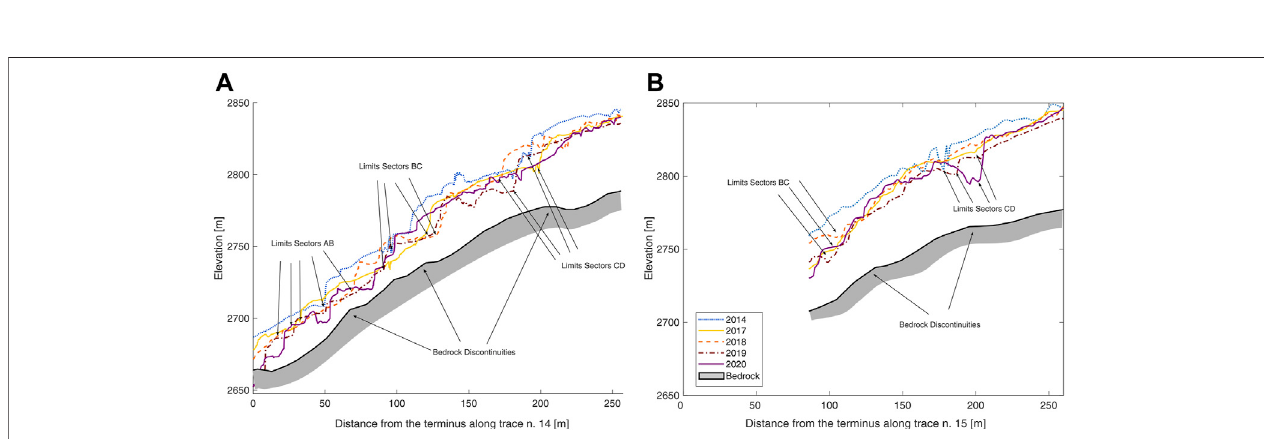
FIGURE7| Correspondencebetweenbedrockdiscontinuitiesandglaciersurfacerecurrentfracturesbetween2014and2020.Thelongitudinalsectionsaretaken in correspondence of GPR pro fi les n. 14 (A) and 15 (B) .